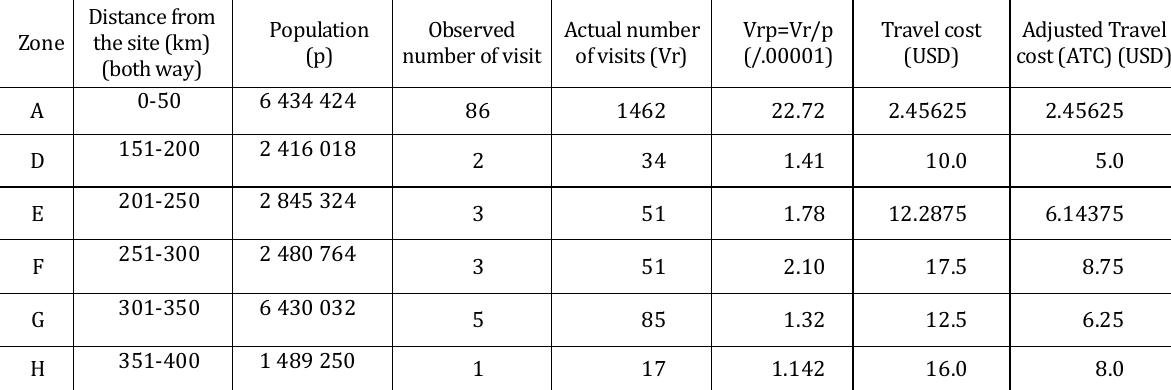
Table1. Zonal model of the TCM